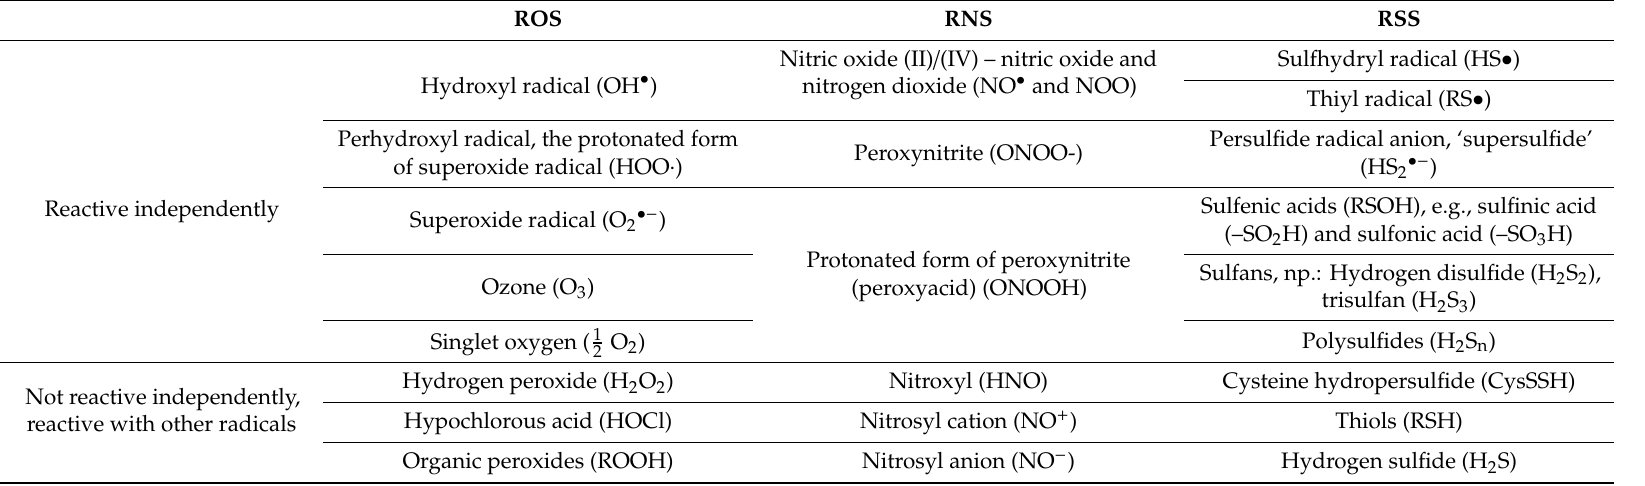
Table 1. Selected biologically important reactive oxygen species (ROS), reactive nitrogen species (RNS), reactive sulfur forms